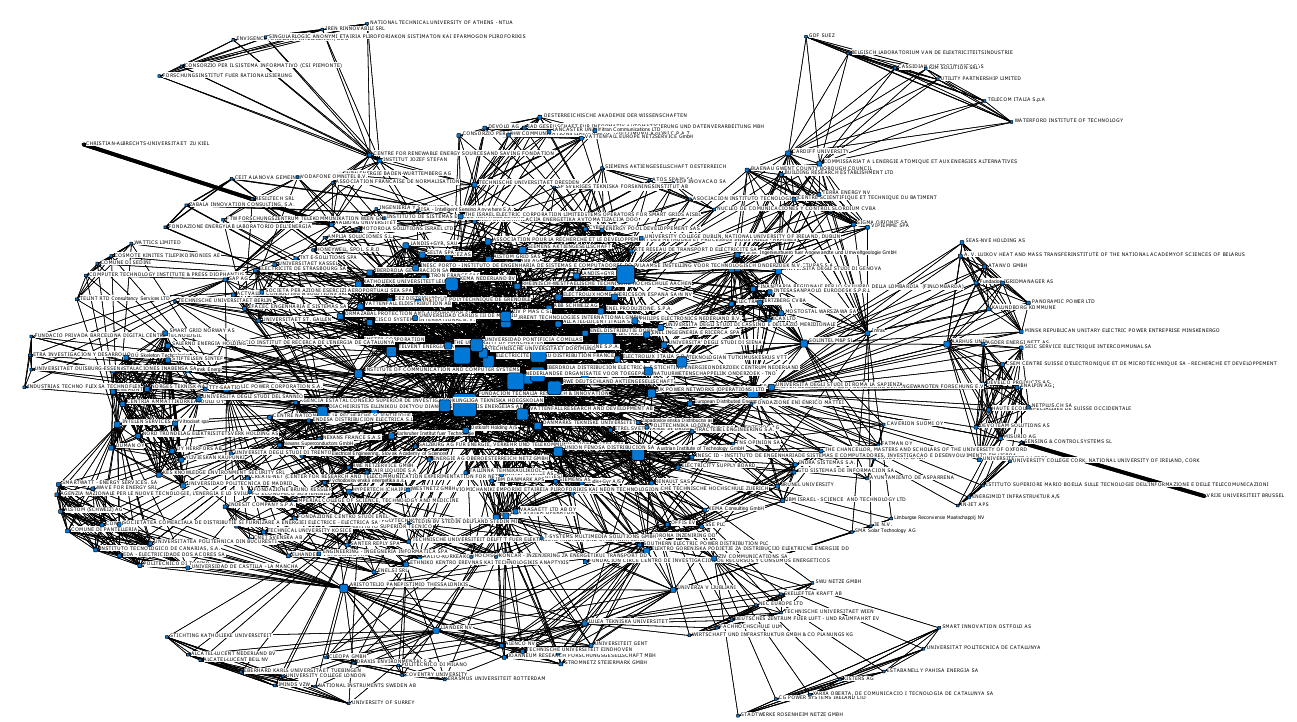
Figure 6. FP7 Distribution Grid projects. Social network based on Freeman degree centrality, main subnetwork (N = 45